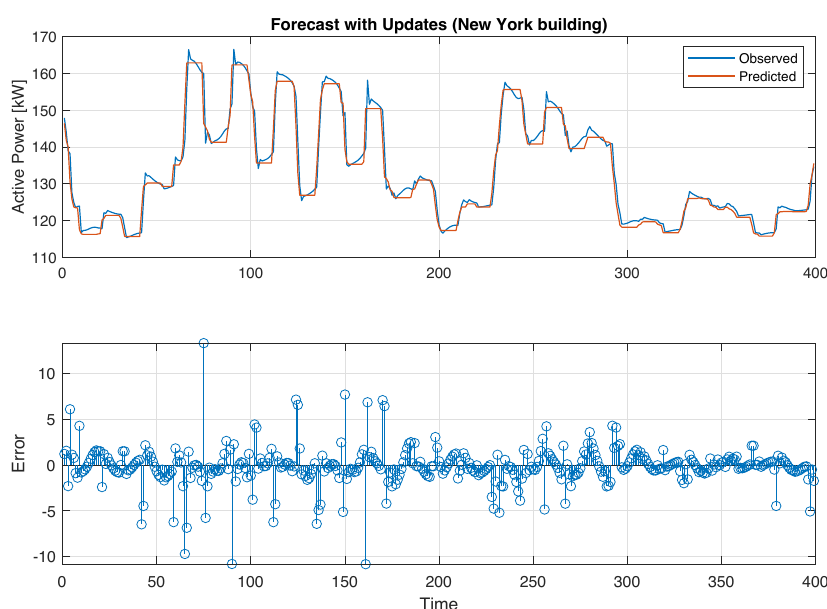
Figure 8. Building load forecasting with 50 unit RNN LSTM: New